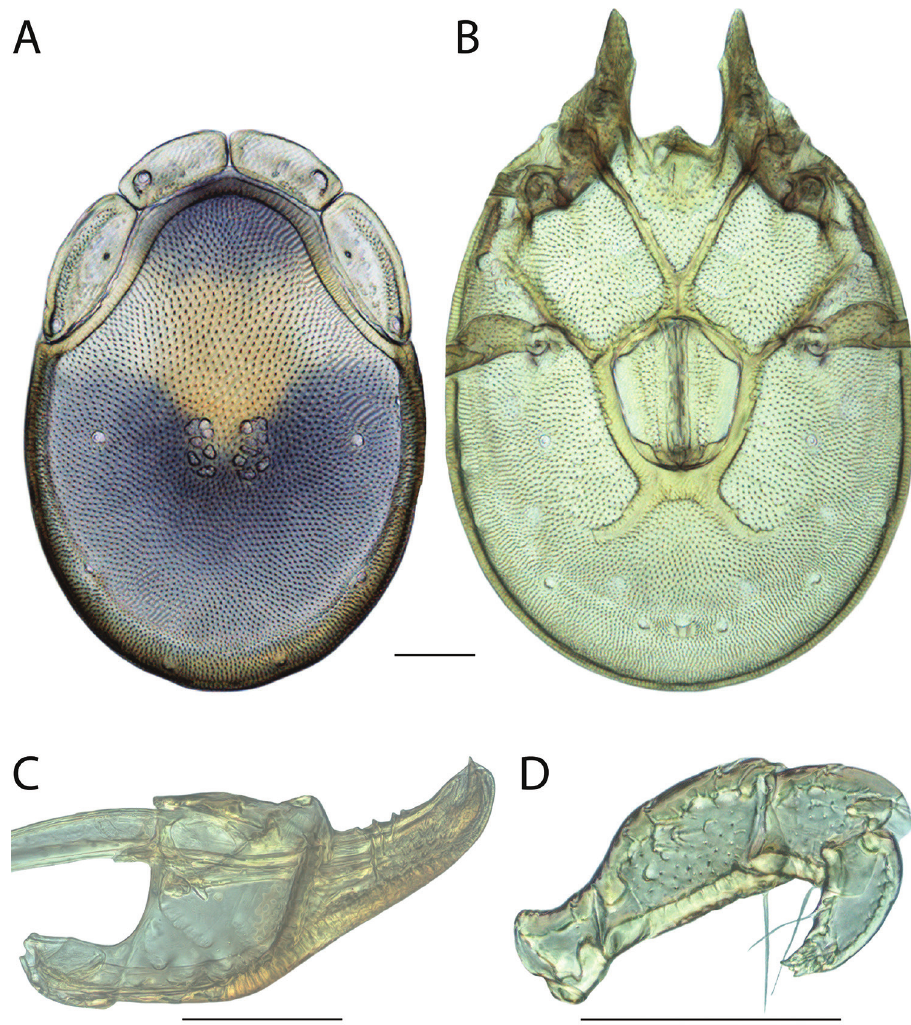
Figure 73. Torrenticola erectirostra sp. n. female: A dorsal plates B venter (legs removed) C subcapitulum D pedipalp (setae not accurately depicted). Scale = 100